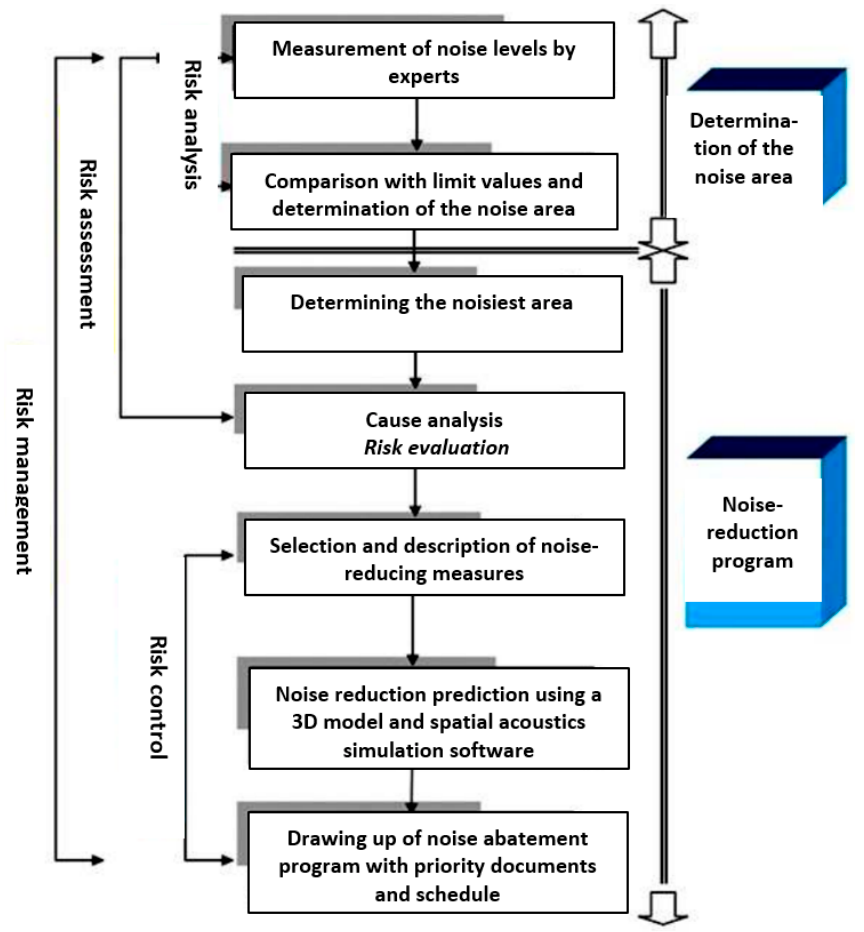
Figure 4. Algorithm of risk management in the field of acoustics [21].